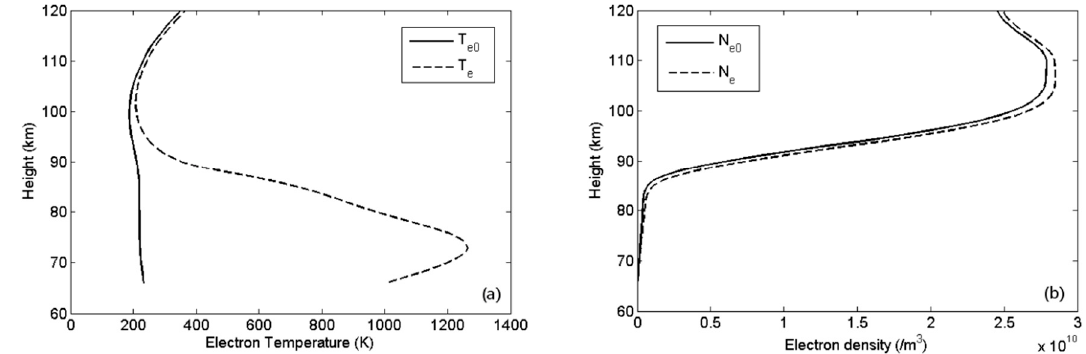
Figure 9. Profile of ( a ) electron temperature and ( b ) electron density before (solid line) and after (dashed line) preheating on 4 December 2018, 1000 UT, EISCAT.